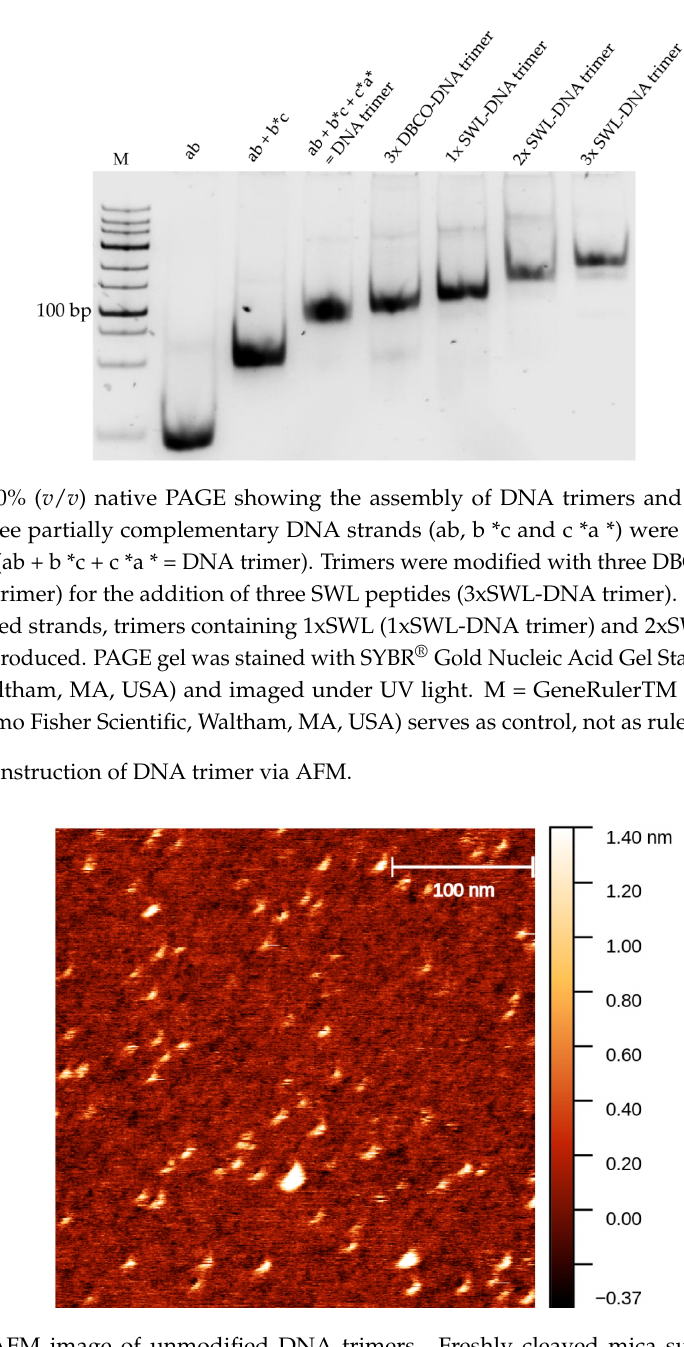
Figure A2. AFM image of unmodified DNA trimers. Freshly cleaved mica surface glued onto a microscopic slide was incubated with 100 µ L Poly-L-ornithin for 10 min at room temperature. Subsequently, the mica was washed three times with 1 × TE/10 mM MgCl 2 buffer followed by application of 20 µ L of 20 µ M DNA trimer for 15 min. A plastic ring was glued around the mica to create a chamber that was filled with 1 × TE/10 mM MgCl 2 buffer to enable measurements in fluid tapping mode. AFM height image was recorded using an SNL-10 (C) cantilever (Bruker AFM Probes, UK) and the atomic force microscope NanoWizard 3.0. (JPK, Berlin, Germany). While the exact trimeric structure is not discernible due to limits in imaging structures of this size, the spots correspond to expected size for trimers of approx. 5–10 nm in